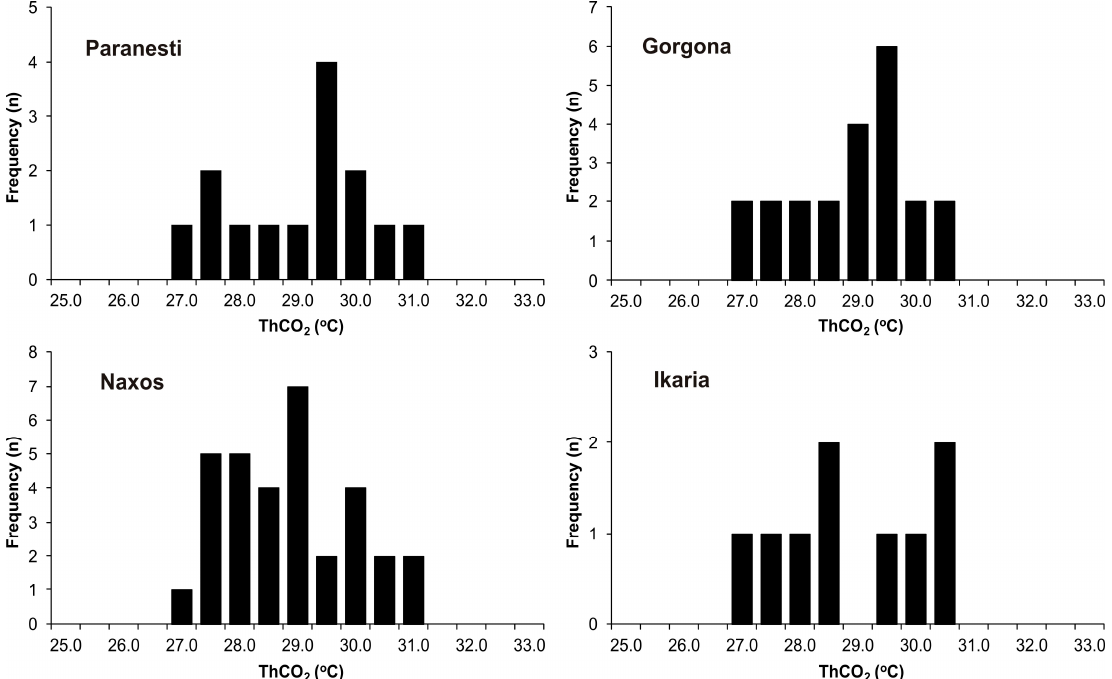
Figure 7. Histograms of homogenization temperatures of CO 2 (ThCO 2 ) to the liquid phase (LCO 2 ) in the fluid inclusion from the Rhodope massif (Paranetsi, Gorgona) and the Attic-Cycladic massif (Naxos, Ikaria) from Greece.